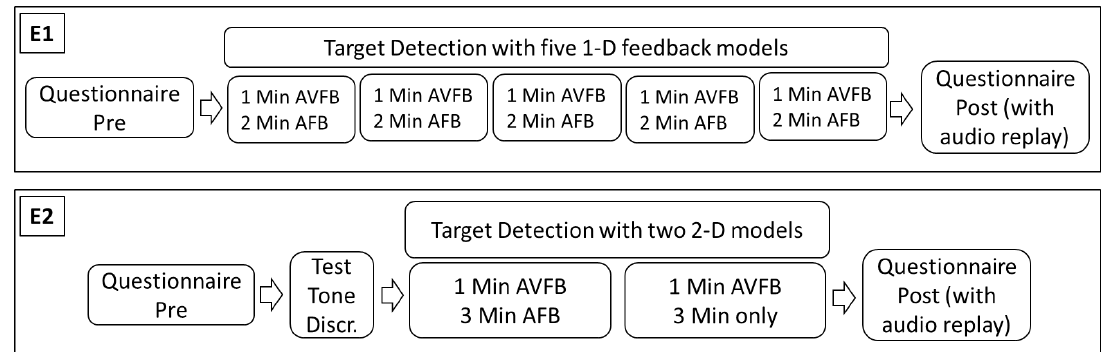
Figure 4. Study procedures of E1 and E2. AVFB = audiovisual condition, AFB = audio-only condition.